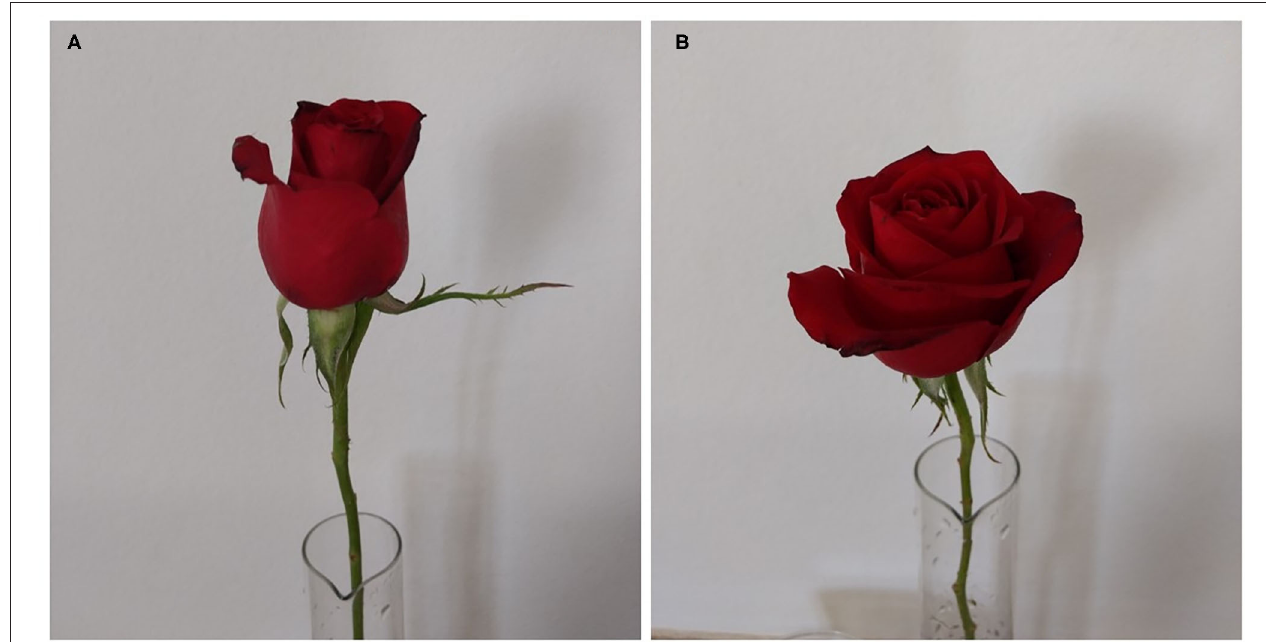
FIGURE 1 | Flower bud opening stages. (A) Bud at the harvest point. (B) Completely open